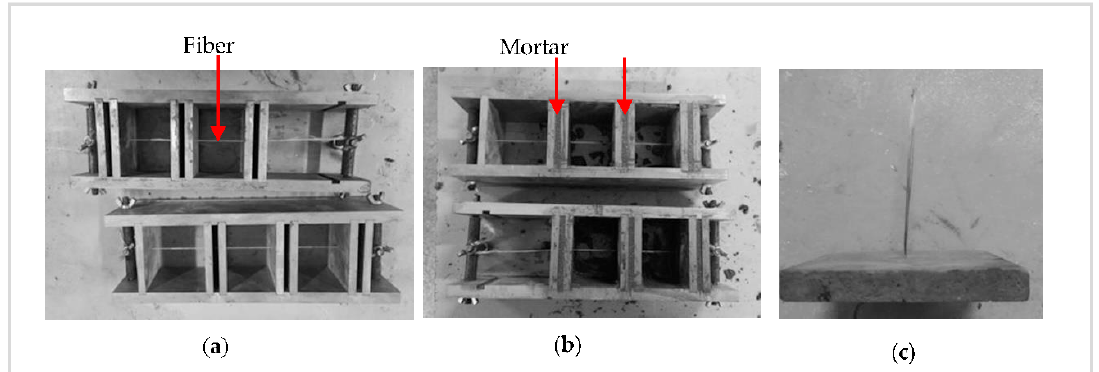
Figure 3. The procedures of fiber pull-out specimen: ( a ) threading the fiber, ( b ) casting the mortar matrix, and ( c ) the pull-out specimen.